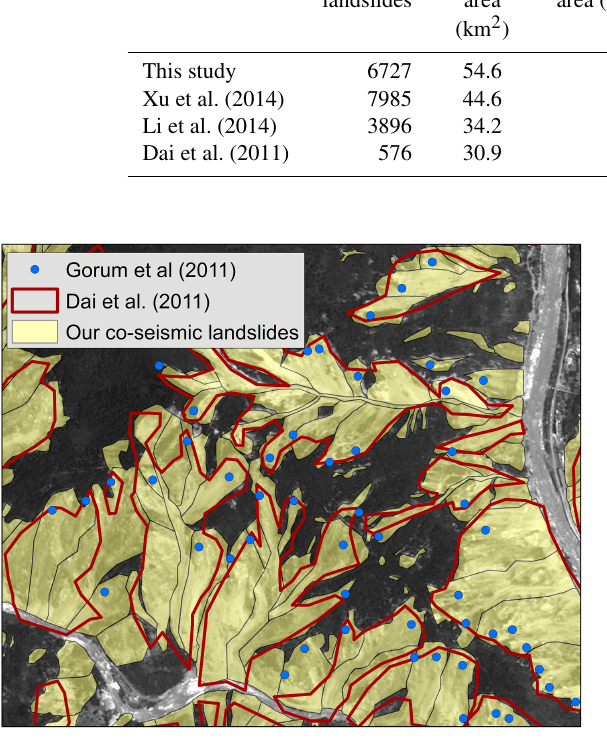
Figure 6. The frequency–area distributions (FAD) of the different co-seismic landslide inventories collected for the study